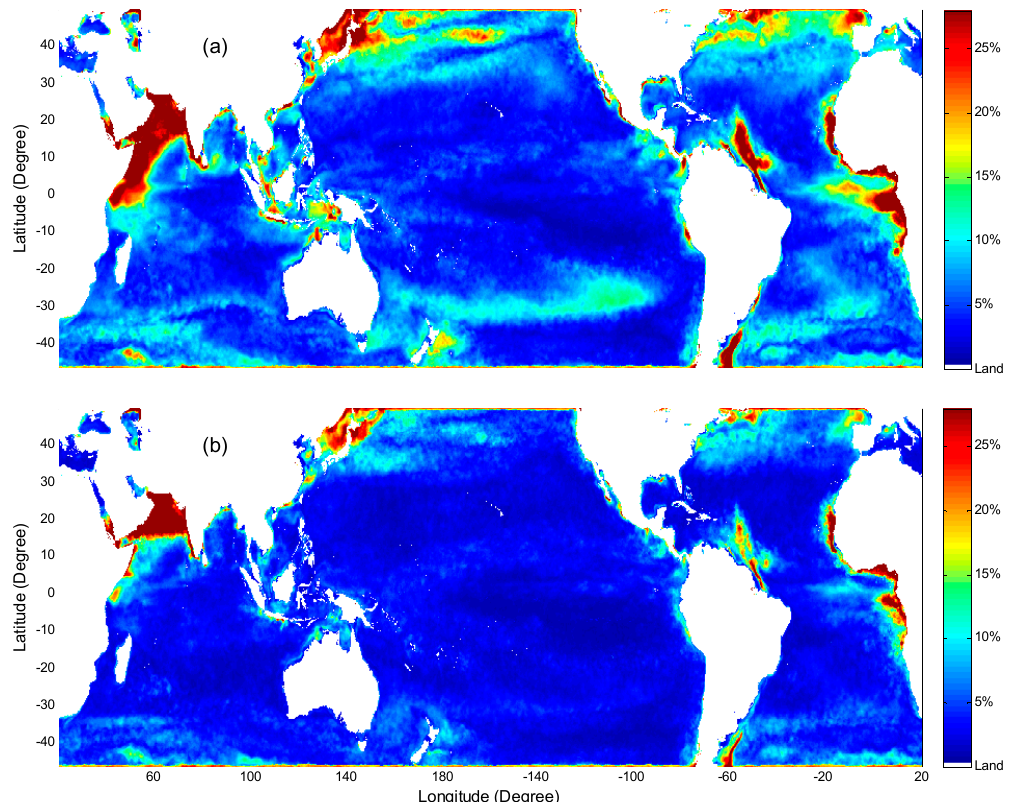
Figure 7. MRD values of Chl-a fitted by Equation (1) ( a ) and Equation (2) ( b ) in the unit of percentage.